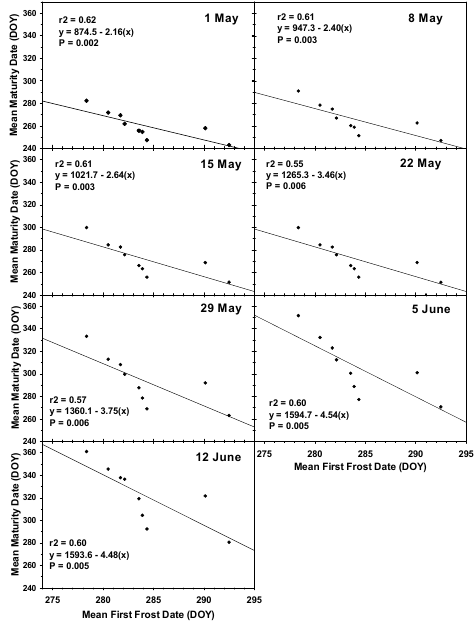
Figure 2. Relationship between mean first frost date and mean maturity date of nine locations in northeastern Colorado for seven planting dates. Dryland (GS) phenological parameters, Early maturity class, and Optimum seedbed water conditions at planting were used for simulating maturity date. If maturity was not predicted by the end of the year, maturity date was set to 31 December. Linear regression lines are given with associated r 2 and probability of significance.